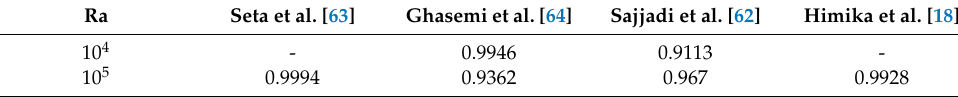
Table 6. Obtained R 2 in each validation segment.